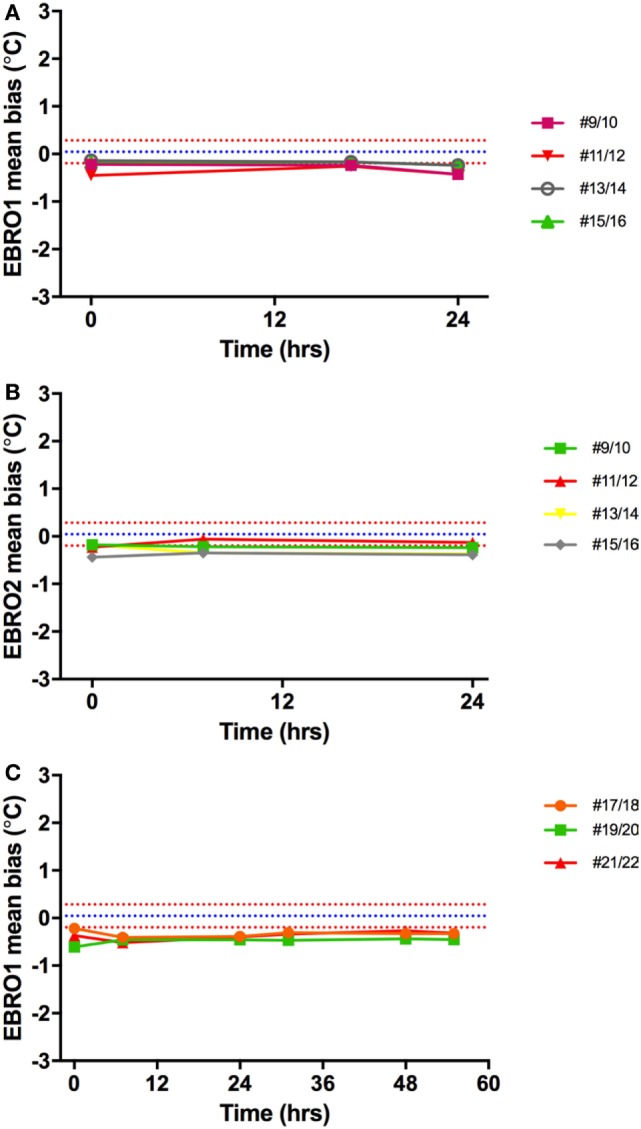
Temperature bias of electronic thermometers vs. Hg thermometers. The mean difference between Hg thermometers and EBRO1 measured over 24 h (A) and 55 h (C), and EBRO2 [24 h; (B)] is shown. Different colored lines represent measurements made on different days simultaneously with core body temperature capsules. Blue and red dashed lines are the mean bias and limits of agreement, respectively, a narrow window of uncertainty due to the potential variability of investigator (parallax error) for reading the Hg thermometer.